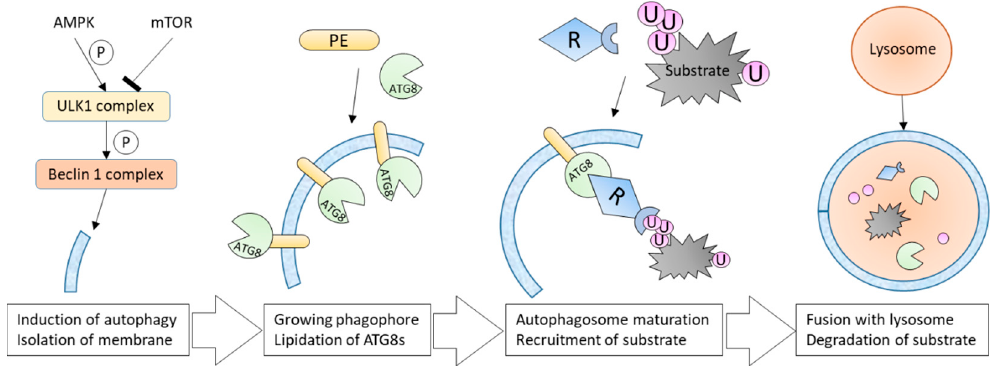
Figure 2. Selective autophagy pathways ensure the degradation of specific cargoes but also bulk of proteins. A complex signaling pathway regulates autophagy and induces the lipidation of ATG8 proteins within the newly formed cup shaped membrane, called phagophore. Recruitment of the autophagy substrate marks the maturation of the autophagosome. The substrate tethering to lipidated ATG8 is ensured by autophagy receptors (R). Autophagosomes then fuse with lysosomes, forming autolysosomes in which trapped substrates are degraded.